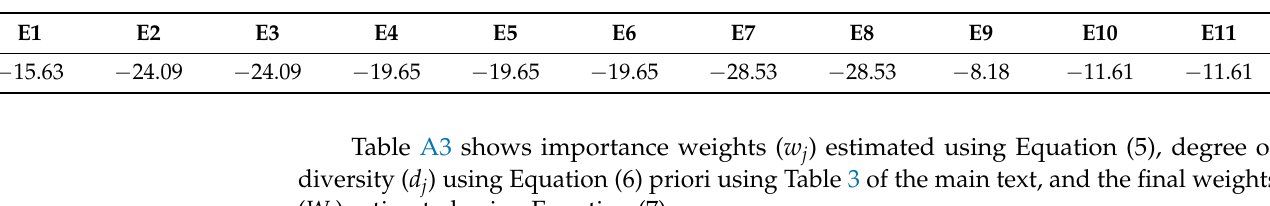
Table A2 presents the entropy matrix ( E j ) developed using Equation (3). Table A2. Entropy matrix.